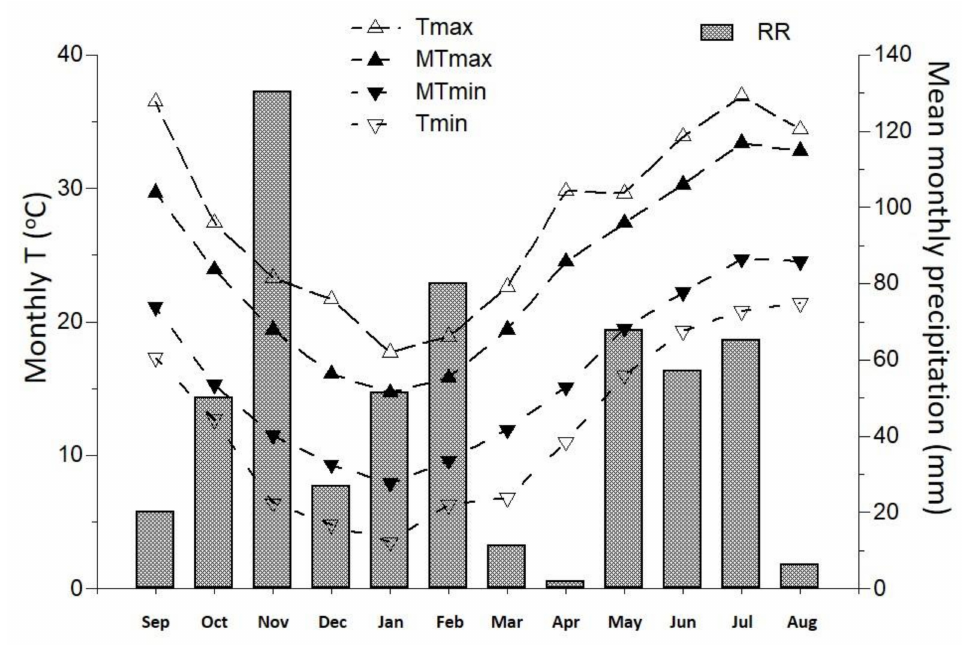
Figure 1. Monthly maximum (Tmax), average maximum (MTmax), average minimum (MTmin), and minimum (Tmin) and precipitation (RR) during the 1st experimental year (September 2017–August 2018) in Athens,